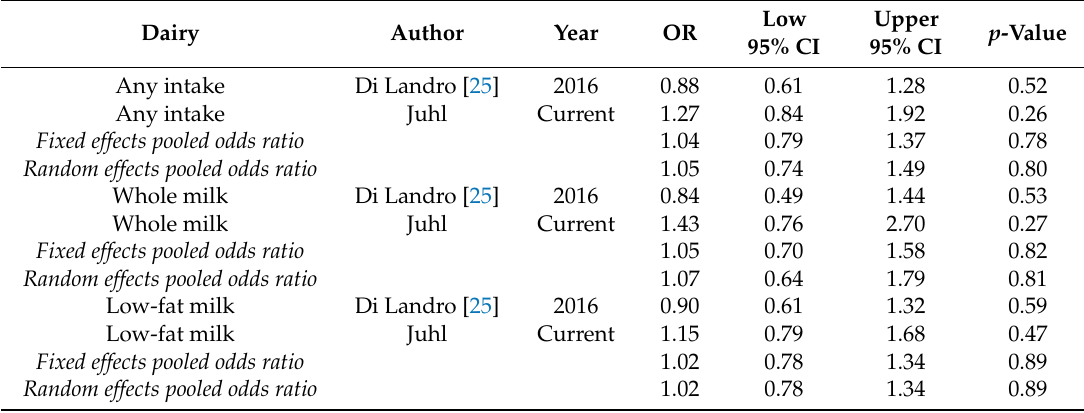
Table 6. Meta-analysis of milk intake and acne in